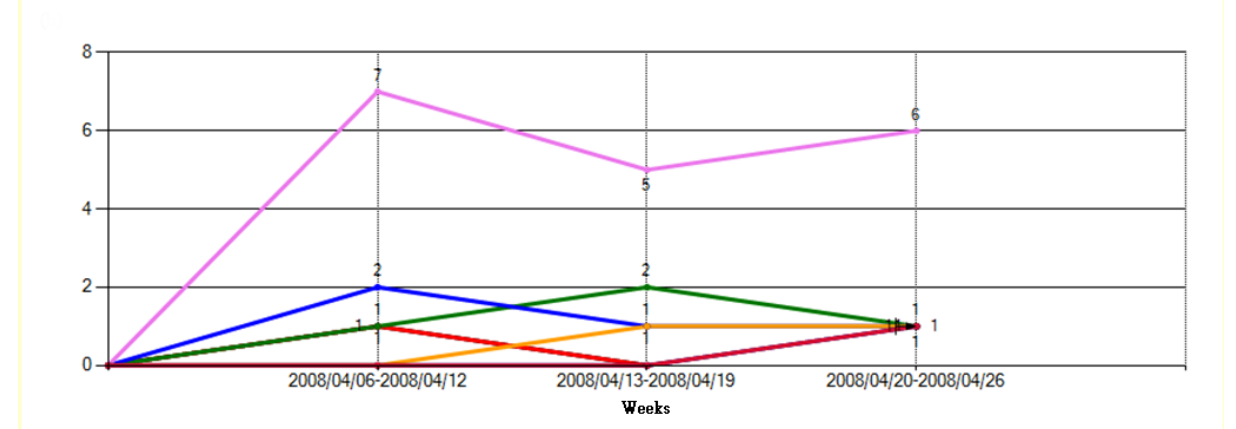
Figure 8. Line chart for visualization of the time trend of MDRO clustering results. This chart display the number of clustered vancomycin-resistant Enterococcus faecium isolates (germ criteria, y-axis), from April 6, 2008, to April 26, 2008, with Euclidean distance equal to zero and single